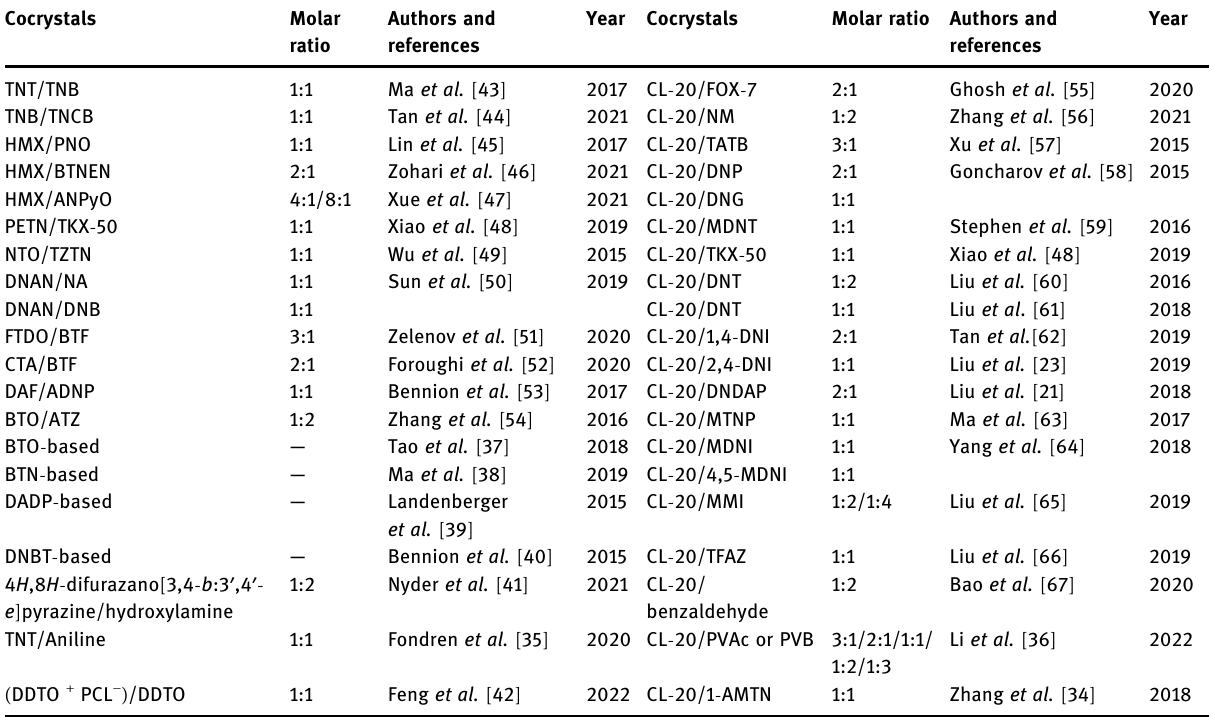
Table 1: Cocrystal energetic materials successfully prepared in recent years Cocrystals Molar Authors and ratio